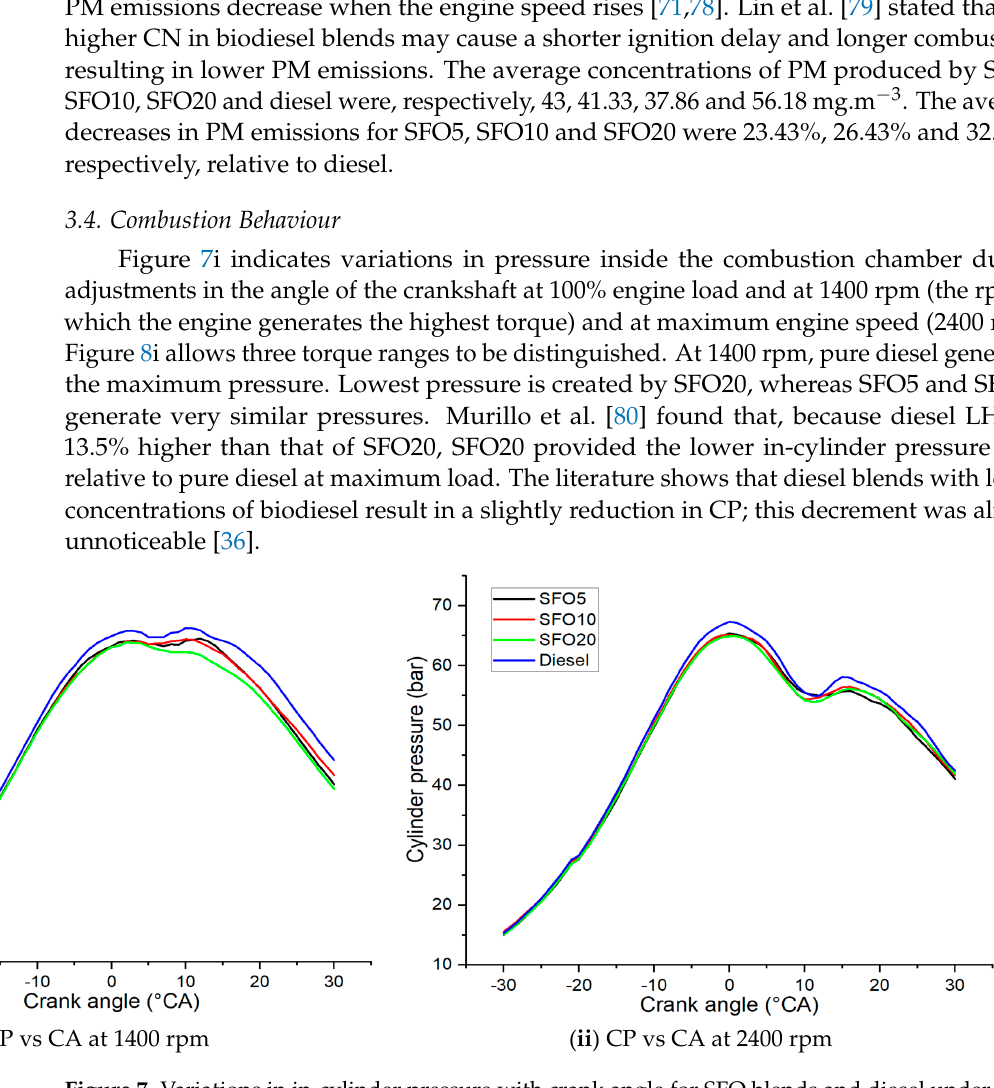
Figure 7. Variations in in-cylinder pressure with crank angle for SFO blends and diesel under 100% engine load at speeds of ( i ) 1400 rpm and ( ii ) 2400 rpm.